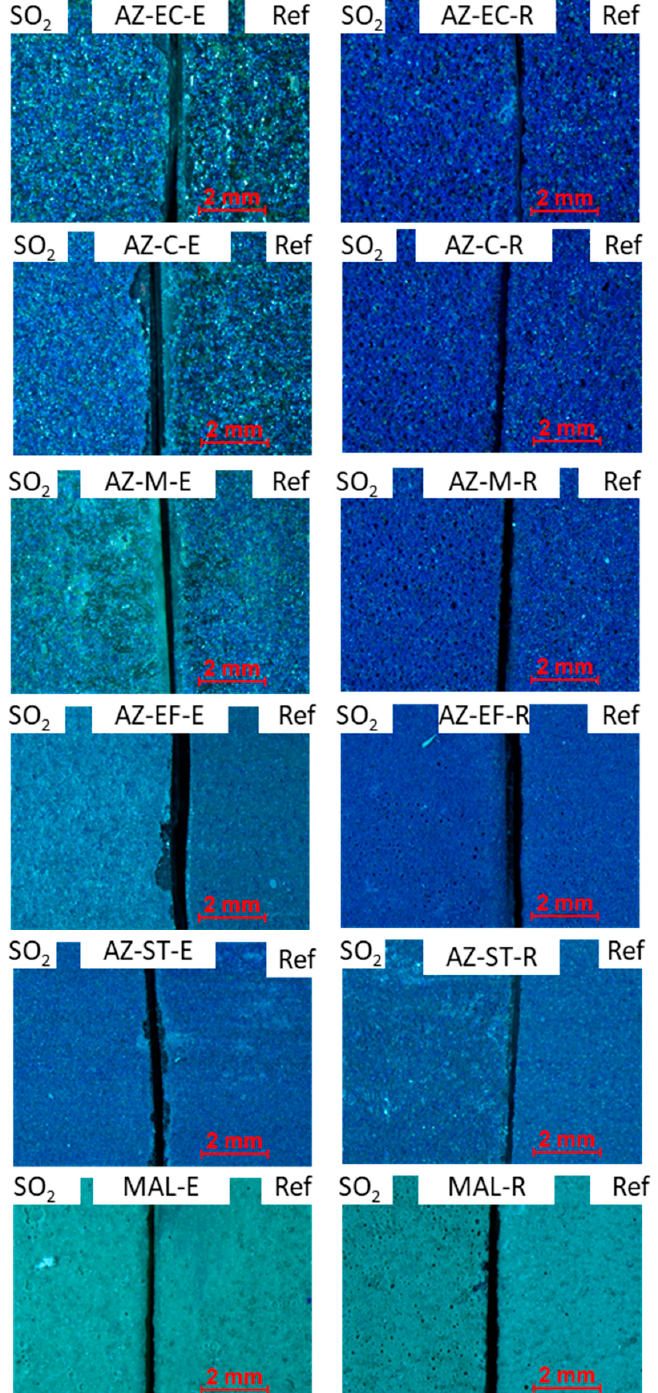
Figure 1. Stereomicroscope micrographs of aged (SO 2 ) and reference (Ref) azurite (AZ) and malachite (MAL) mock-ups based on egg yolk (E) and rabbit glue (R). EC: extra coarse grain size; C: coarse grain size; M: medium grain size; EF: extra fine grain size; ST: standard grain size.